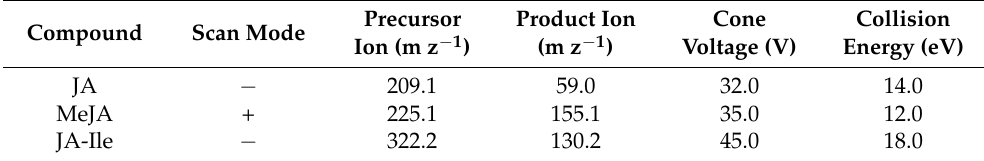
Table 1. Mass spectrometry optimization conditions in multiple reaction monitoring mode.